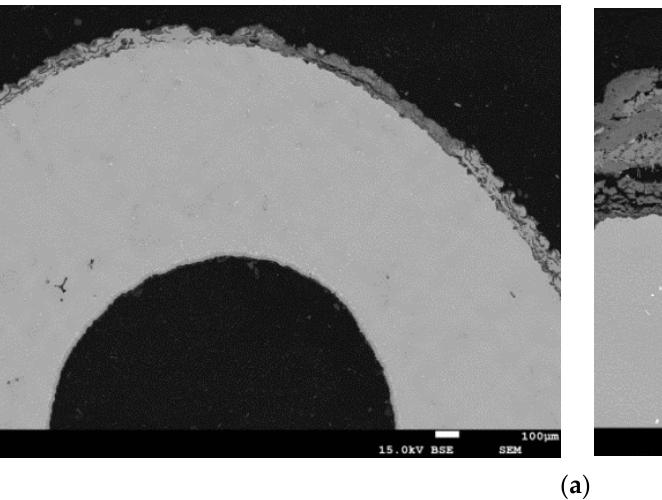
Figure 13. Distribution of microhardness on the leading edge for the protective coating made using the APS + TBC method.